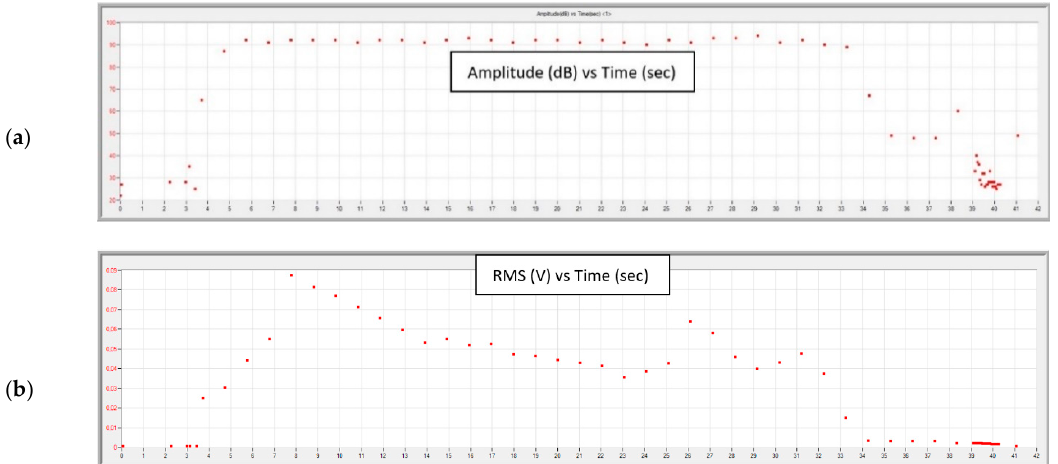
Figure 17. Charts of ( a ) amplitude and ( b ) RMS changing as a function of time during turning with parameters: ap = 2.0 mm, f = 0.075 mm/rev.